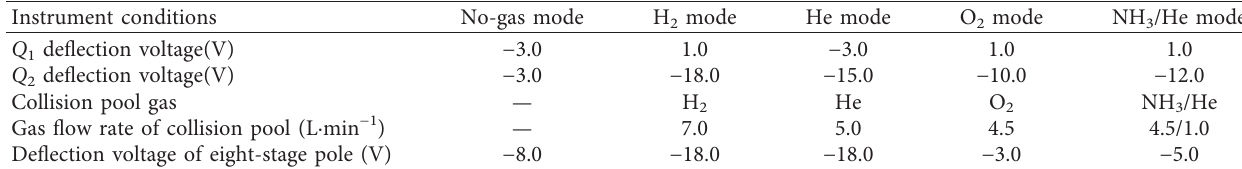
Table 2: Instrument parameters of ICP-MS/MS.